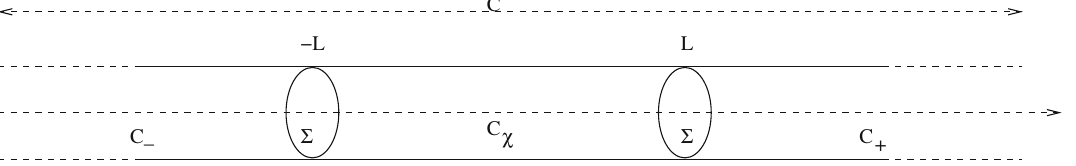
in the text as (cid:10) ± L are for simplicity both indicated with (cid:10) . Again, for simplicity, we have not indicated the other boundaries we take into consideration in the main